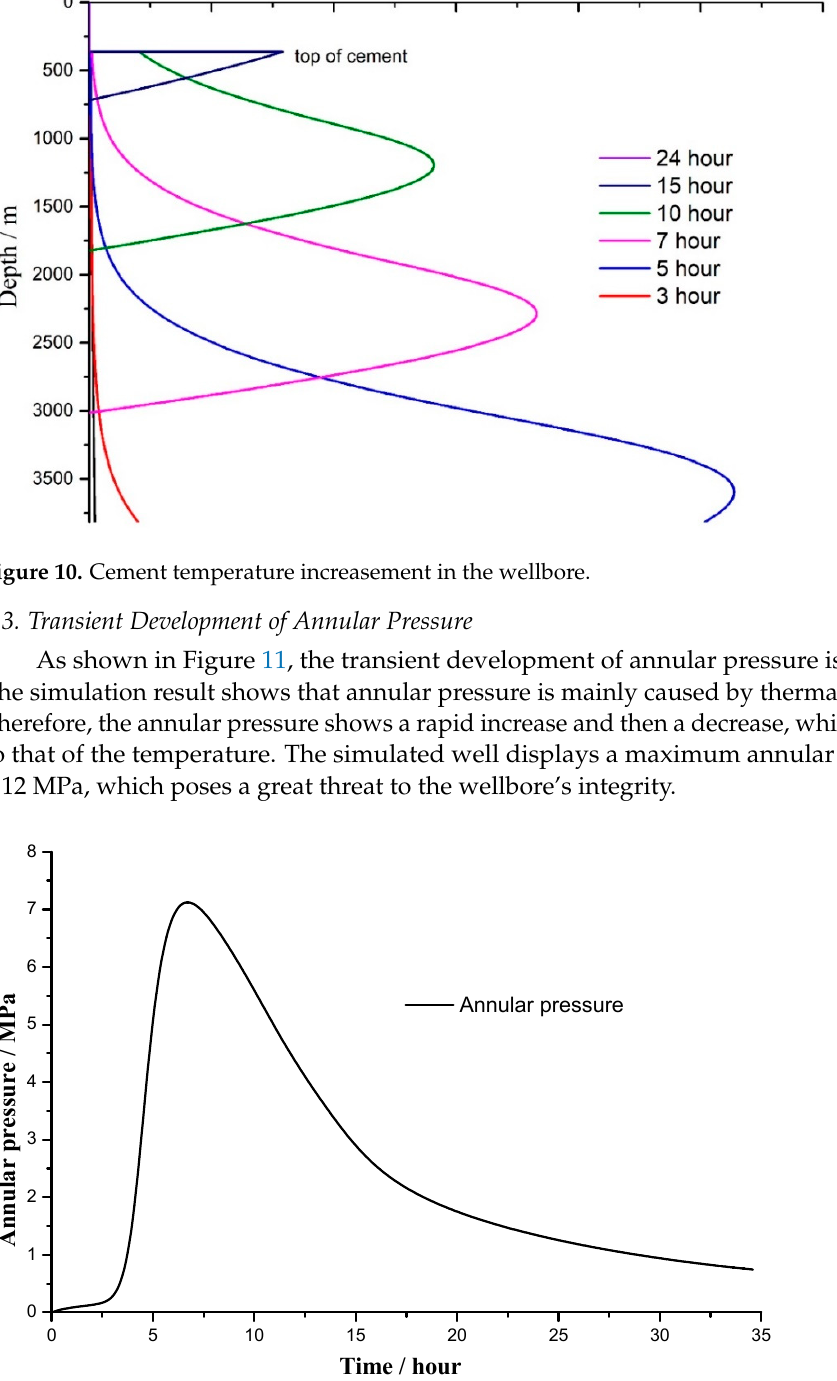
Figure 9. Transient distribution of cement temperature in the wellbore.